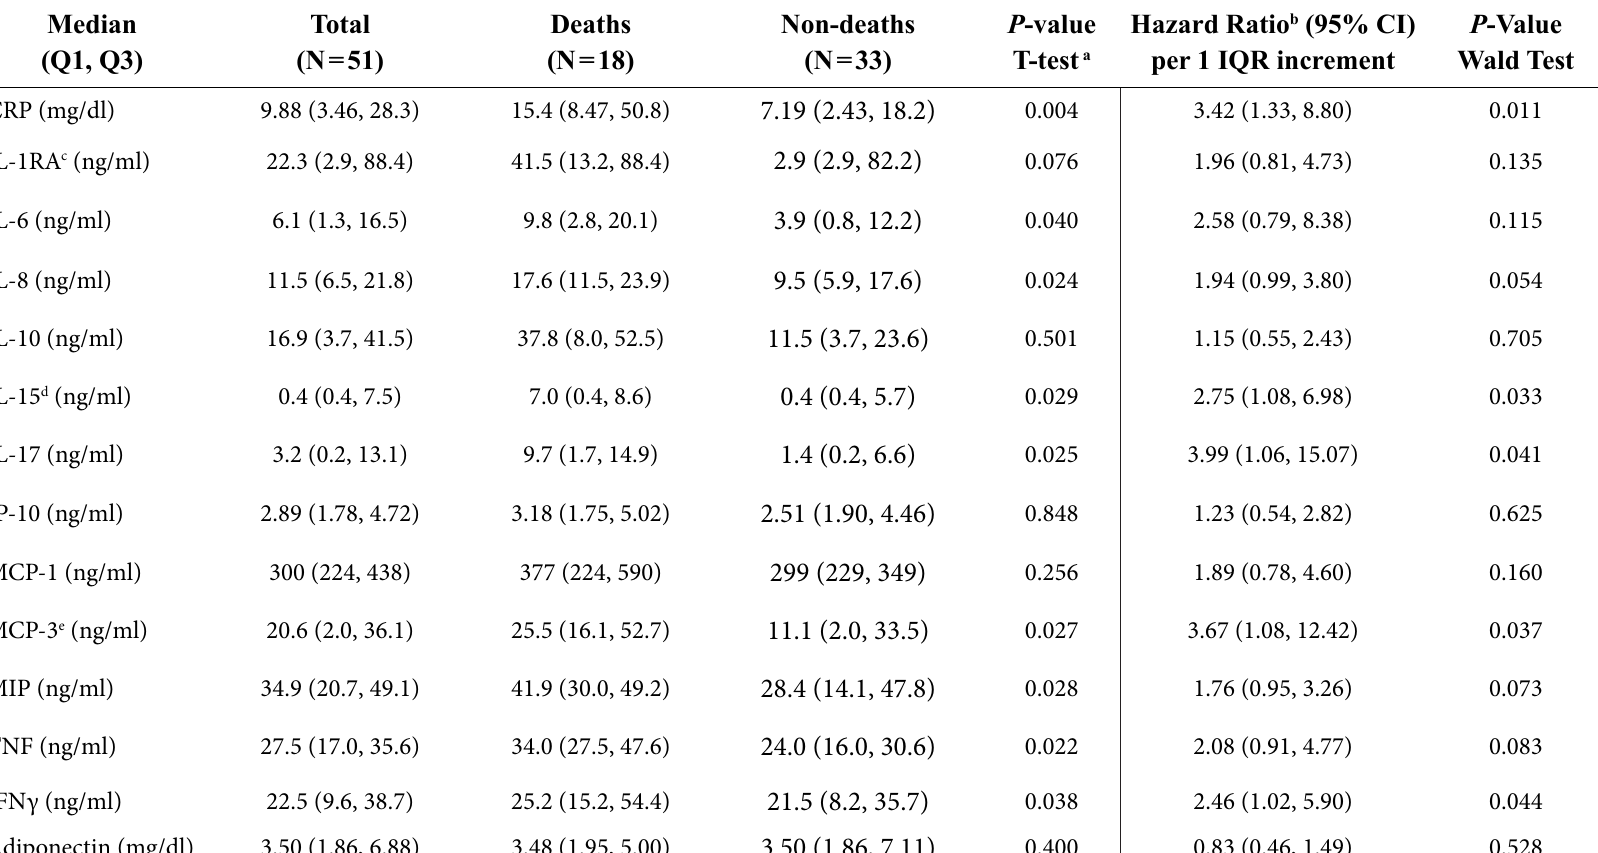
Table 3: Markers of Inflammation at Baseline and Association with Risk of Death